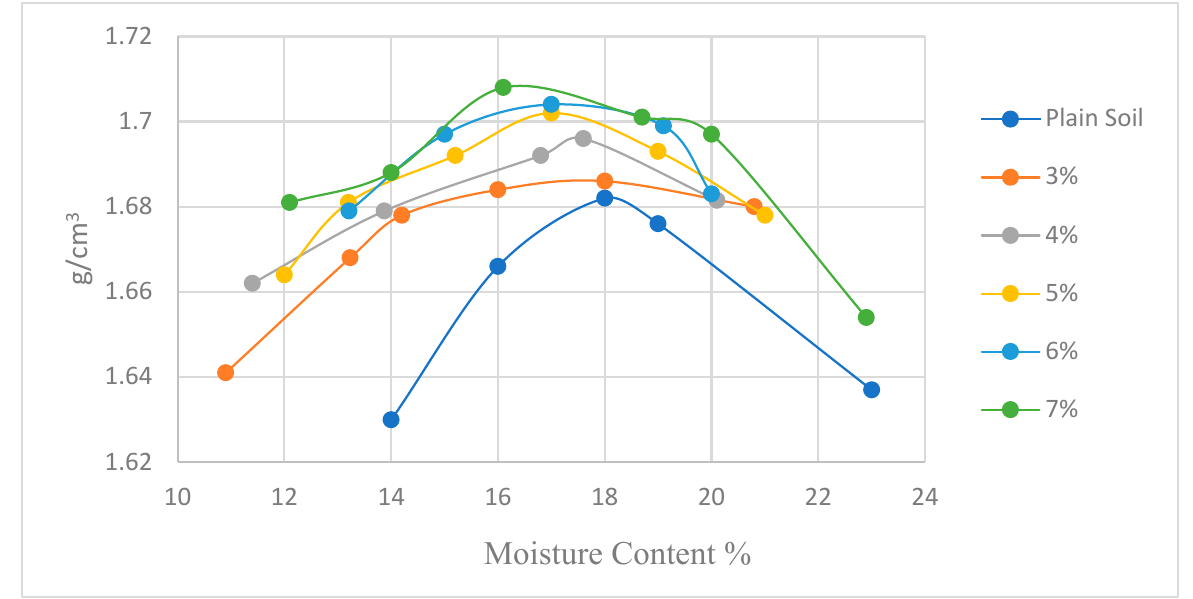
Figure 6. Compaction curves for different cement parameters showing the dry density of different mixtures.